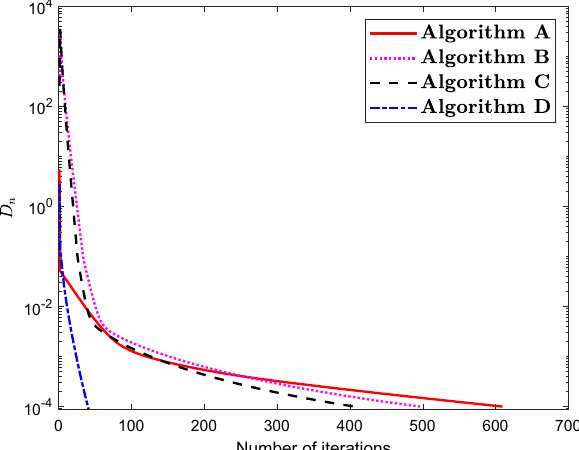
Fig. 4 Numerical illustration of Algorithm 1 with Algorithm 1 in [16] and Algorithm 3.1 in [1] and Algorithm 3.1 in [27] while m =